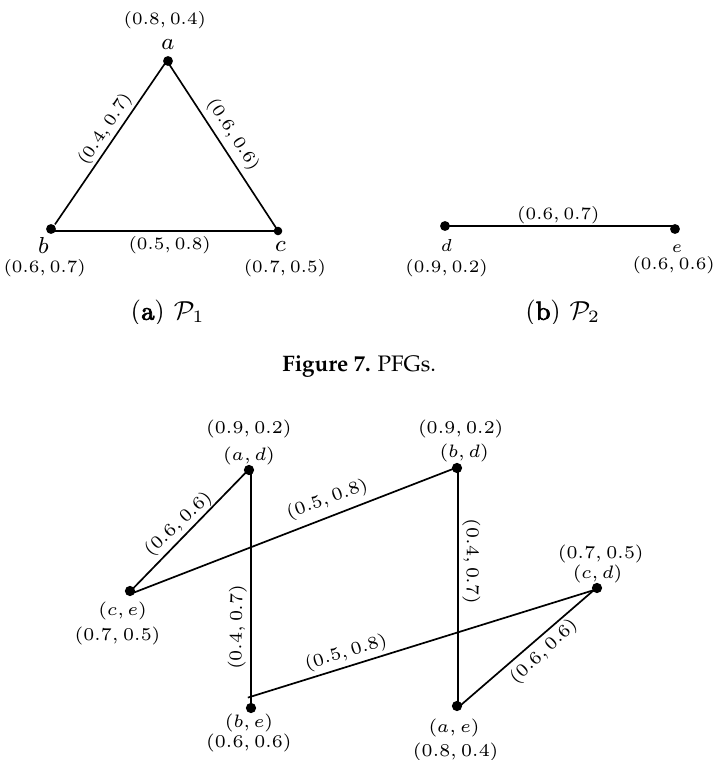
Figure 2.7: Residue product of two PFGs.